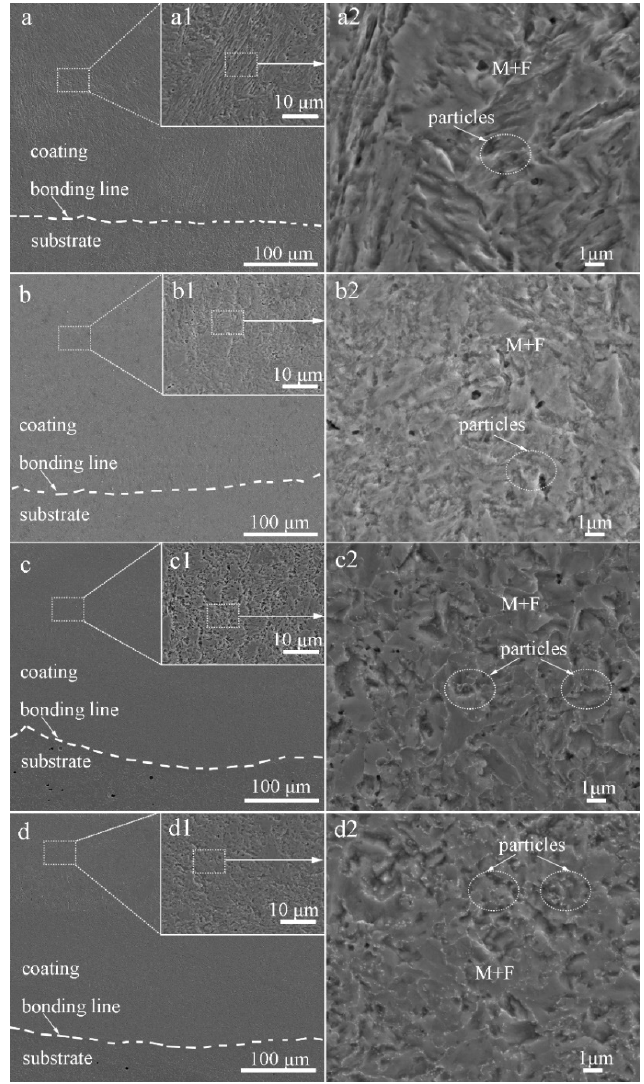
Figure 3. SEM images of the laser-cladded MSS coatings with different V contents: ( a ) 1# (0 wt%V); ( b ) 2# (0.25 wt%V); ( c ) 3# (0.5 wt%V); and ( d ) 4# (1 wt%V).